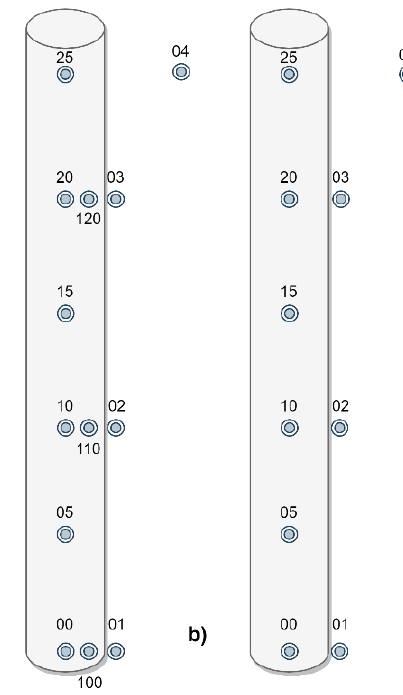
Figure 7. Experimental probes: ( a ) PPR and ( b ) HDPE.